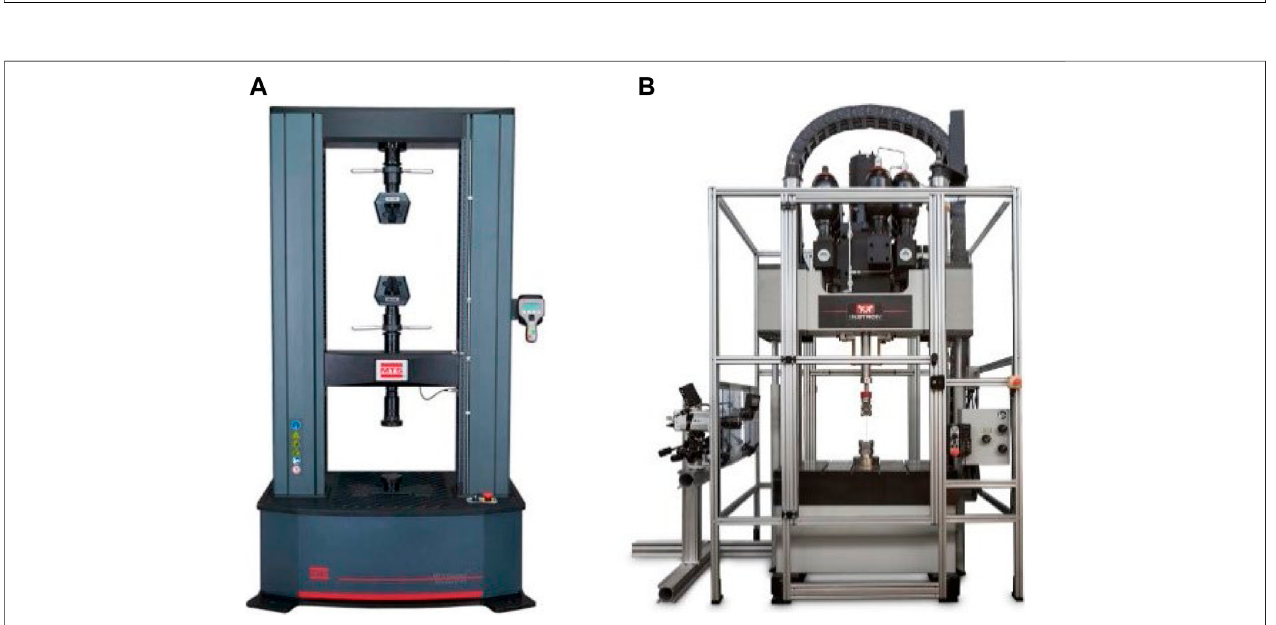
FIGURE 3 | Compressive testing machines for the experiments: (A) Universal testing machine for quasi-static tests, (B) Instron high rate testing system for dynamic tests.